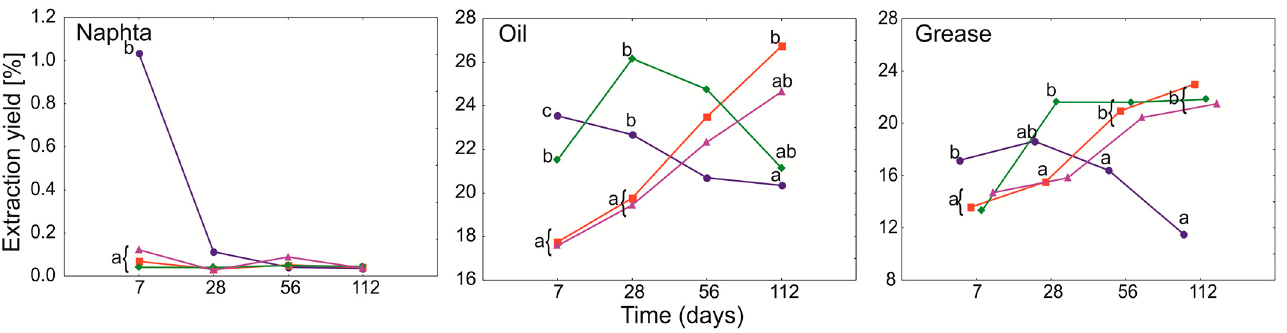
Figure 1. GLMM for mean extract yield of heavy naphtha, lubrication oil, and grease for PGA treatment (blue and circle—PGA 0 , red and square—PGA 1 , green and diamond—PGA 1B , violet and triangle—PGA 10 ) and time (days). The different letters indicate the pairwise differences according to Duncan pairwise test. Mean values, standard error and confidence intervals are included in Supplementary Material Table S1.